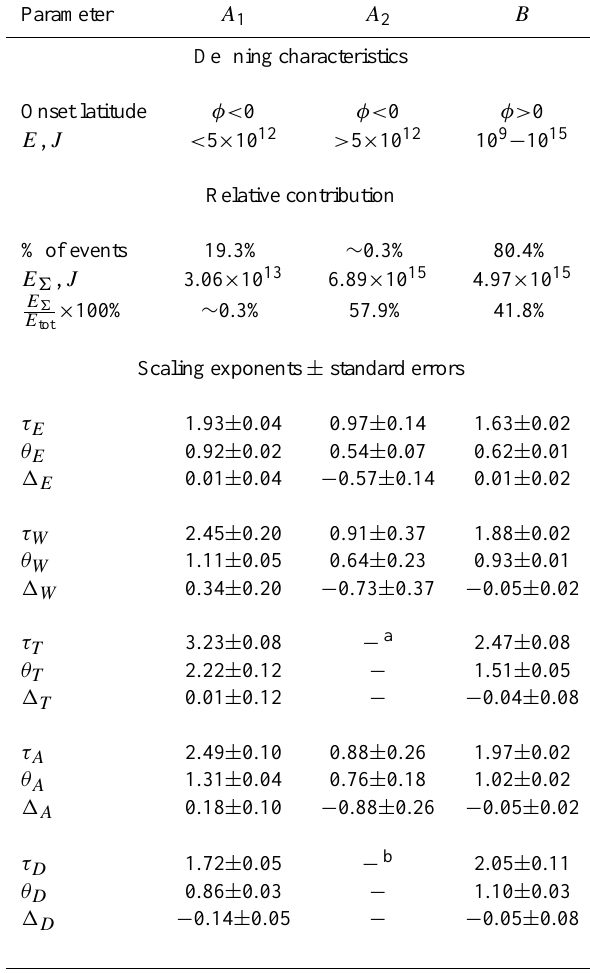
Table 1. Comparative parameters of the three scaling modes of the emission